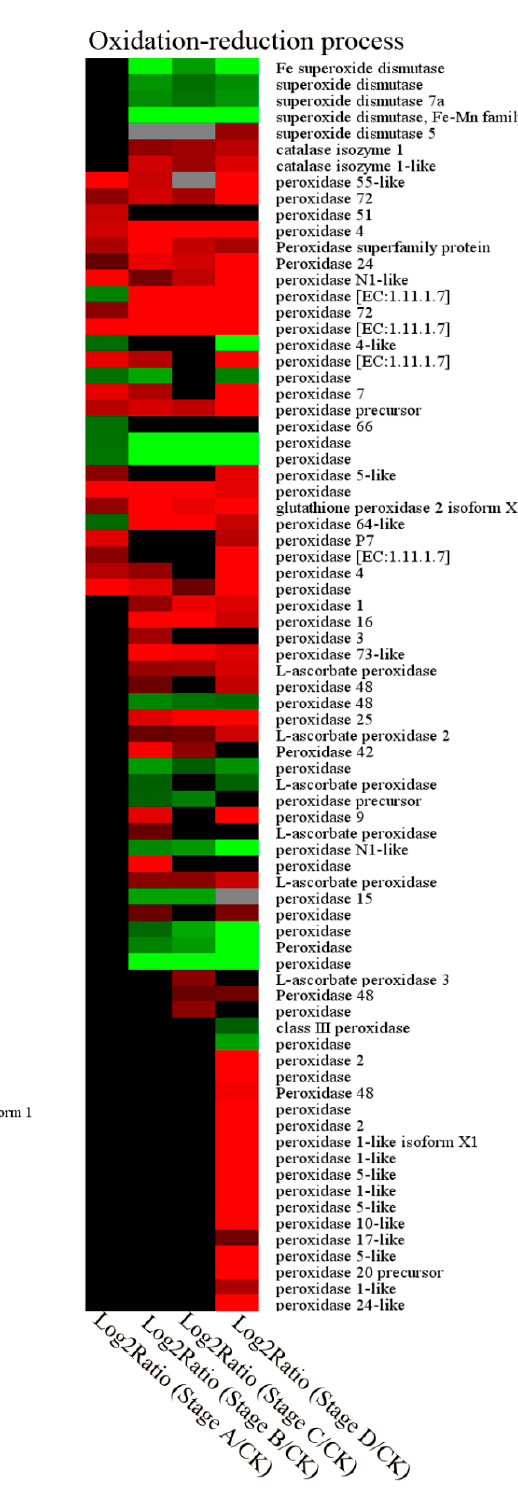
Figure 7. Expression profiles of DEGs involved in JA, SA, Ca 2+ signaling and oxidation–reduction process.